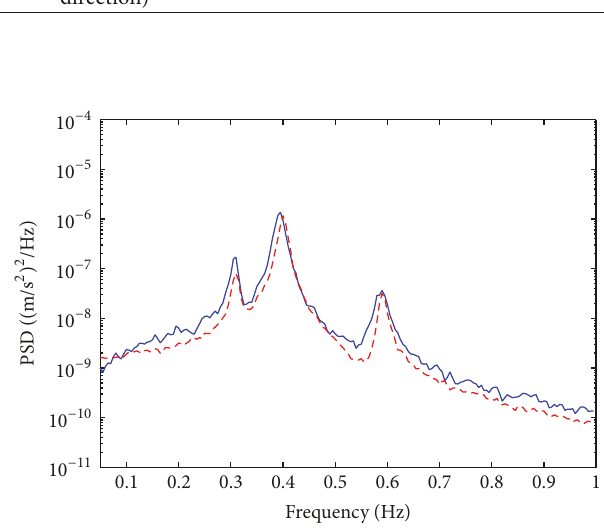
Figure 2: Experimental (solid curve) and numerical (dashed curve) PSD for an accelerometer on floor 30 in case of low